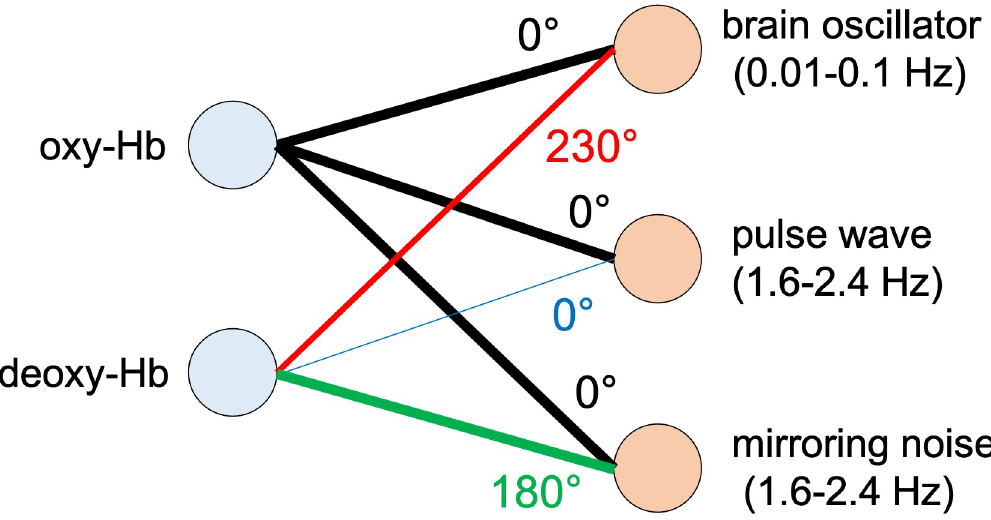
Fig 13. Projection pattern of three types of oscillators in infant